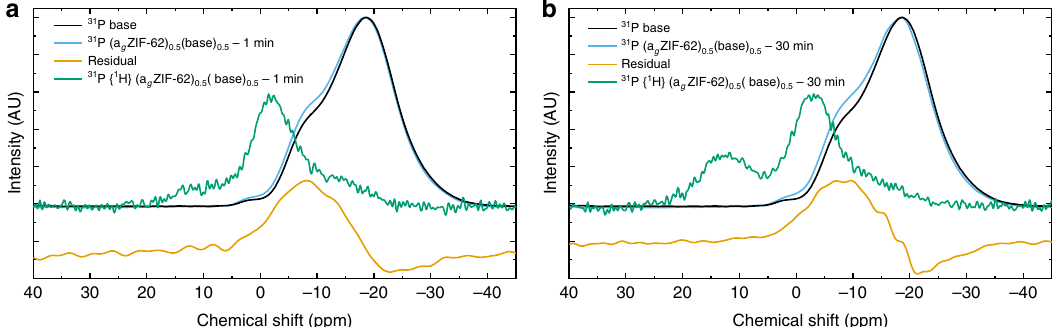
Fig. 6 NMR spectroscopy. 31 P SS NMR and 31 P{ 1 H} CP NMR of the inorganic glass (base) and the composites (a g ZIF-62) 0.5 (base) 0.5 samples. a (a g ZIF- 62) 0.5 (base) 0.5 – 1 min and b (a g ZIF-62) 0.5 (base) 0.5 − 30 min.